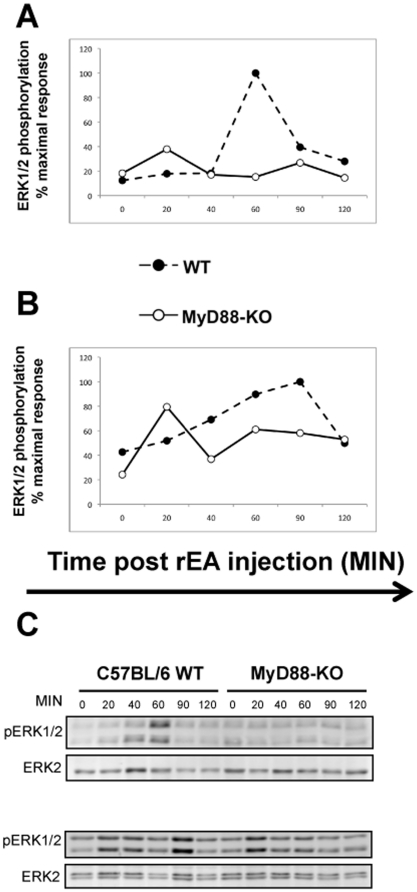
rEA-triggered Erk1/2 phosphorylation is MyD88 dependent.C57BL/6 WT or MyD88-KO mice were injected with 100 ng of rEA. Spleen (A) and liver (B) tissues were collected at the indicated time points and processed as described in Materials and Methods. p-Erk1/2 and Erk2 levels were determined by Western blot analysis using LI-COR Odyssey. To control for loading, quantification was performed after normalizing the pErk1/2 to Erk2 levels. Three independent experiments representative of this data are shown. (C) Representative blots: spleen (top), liver (bottom).